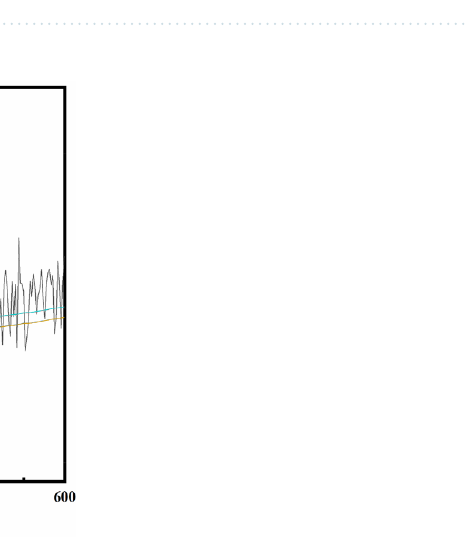
Table 3. Surface functional group content of OS-CS AC.